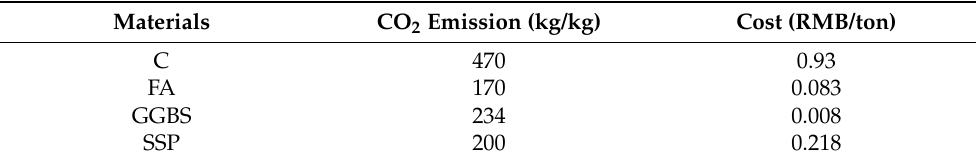
Table 10. Carbon emission and material cost for each component of blended cement.